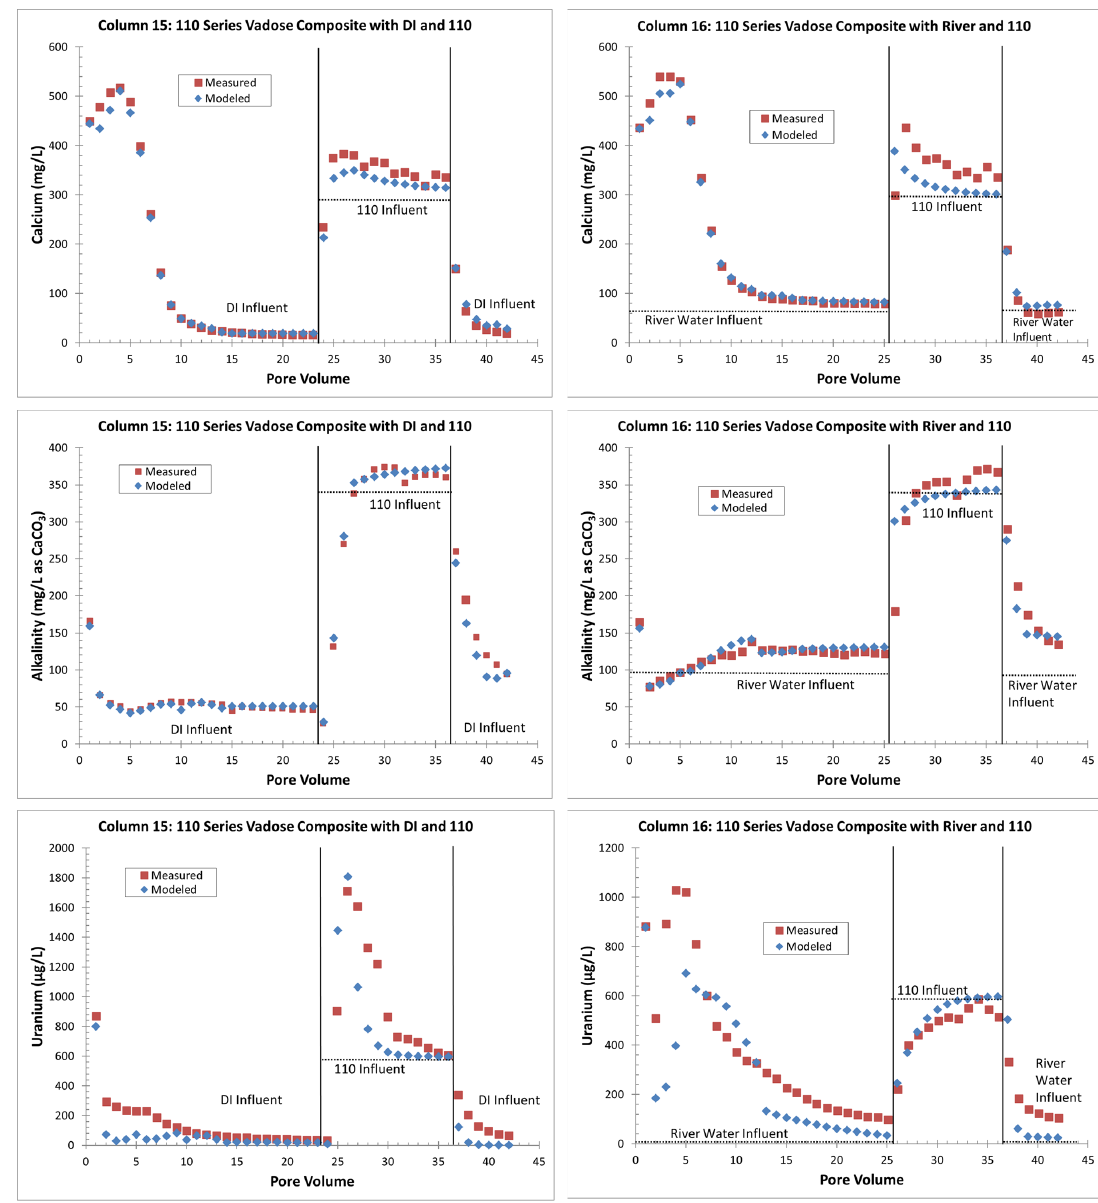
Figure 7. Modeled calcium, alkalinity, and uranium concentrations in columns 15 and 16 compared to measured values. Calcium and alkalinity were controlled by setting the calcite, carbon dioxide, and gypsum SI equal to values determined from the effluent. Additional model parameters included cation exchange and uranium sorption. Modeling was completed in batch mode, so model results are only reported at the specified PV.